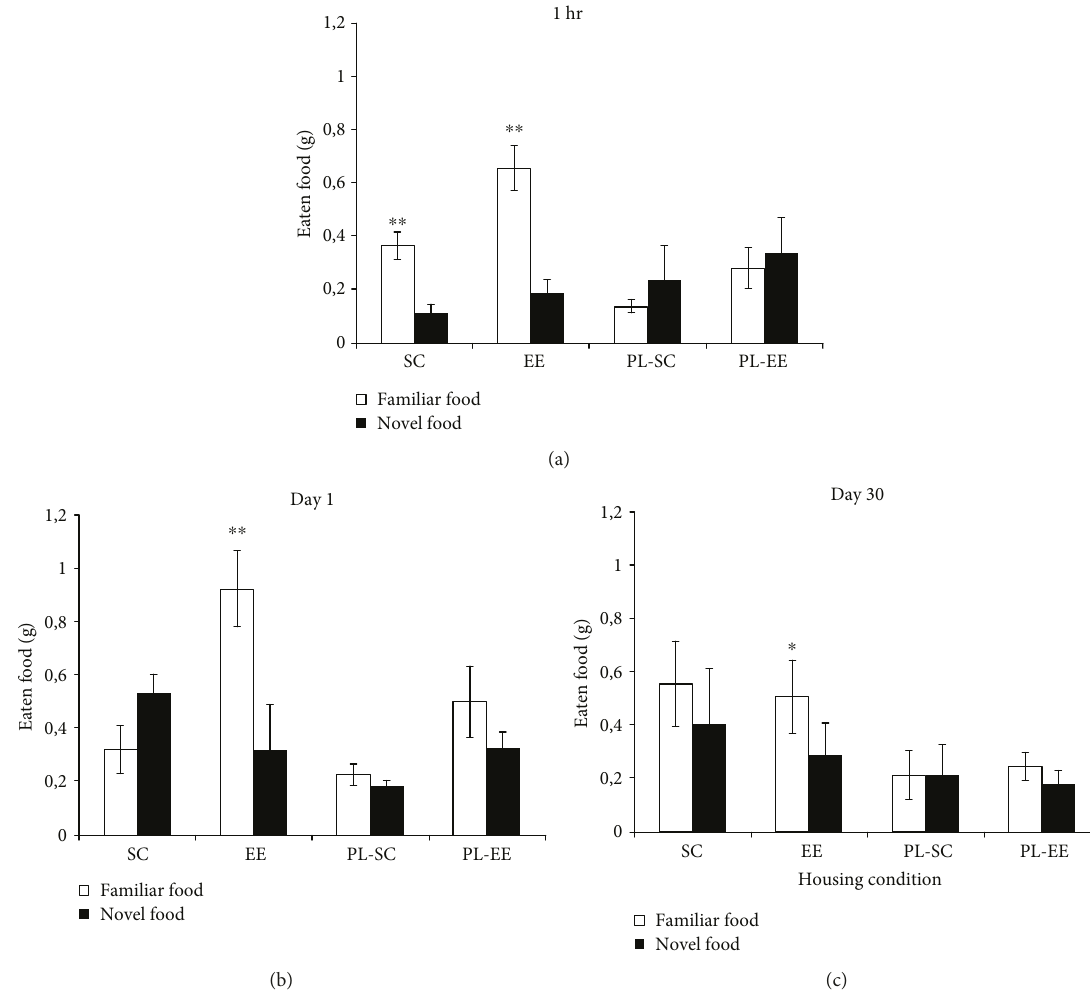
Figure 2: Performance of SC, EE, PL-SC, and PL-EE mice in the STFP. (a) 1-hour retention interval: there is a signi fi cant preference for the familiar food (open columns) with respect to the novel food ( fi lled columns) for SC and EE groups, which underwent associative learning of familiar food in the breath of the demonstrator (two-way RM ANOVA post hoc analysis Holm-Sidak method, familiar food versus novel food for SC ( p = 0 007 ) and EE ( p < 0 001 )). (b) 24-hour retention interval (day 1). There is a signi fi cant preference for the familiar food with respect to the novel food only for EE group (two-way RM ANOVA post hoc analysis Holm-Sidak method, familiar food versus novel food for EE ( p = 0 001 )). (c) 30-day retention interval (day 30): there is a signi fi cant preference for the familiar food with respect to the novel food only for EE group (two-way RM ANOVA post hoc analysis Holm-Sidak method, familiar food versus novel food for EE ( p = 0 021 )). There is no preference for the familiar food in pseudolearning mice, PL-SC and PL-EE, for any time interval (two-way RM ANOVA